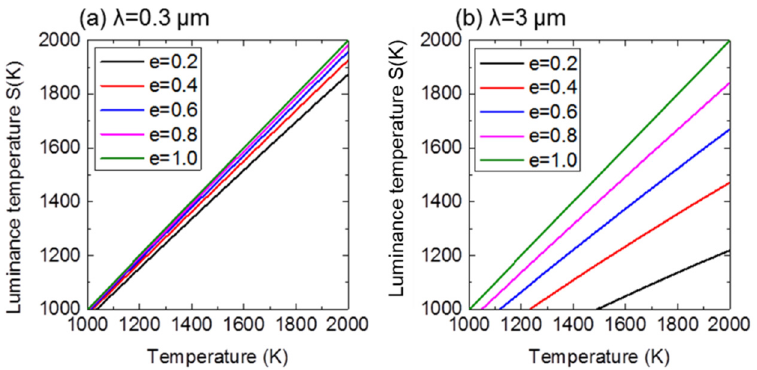
Figure 1. Influence of light wavelength on the difference between S (K) and T (K) at different emissivities: ( a ) λ = 0.3 µ m ( b ) λ = 3 µ m.